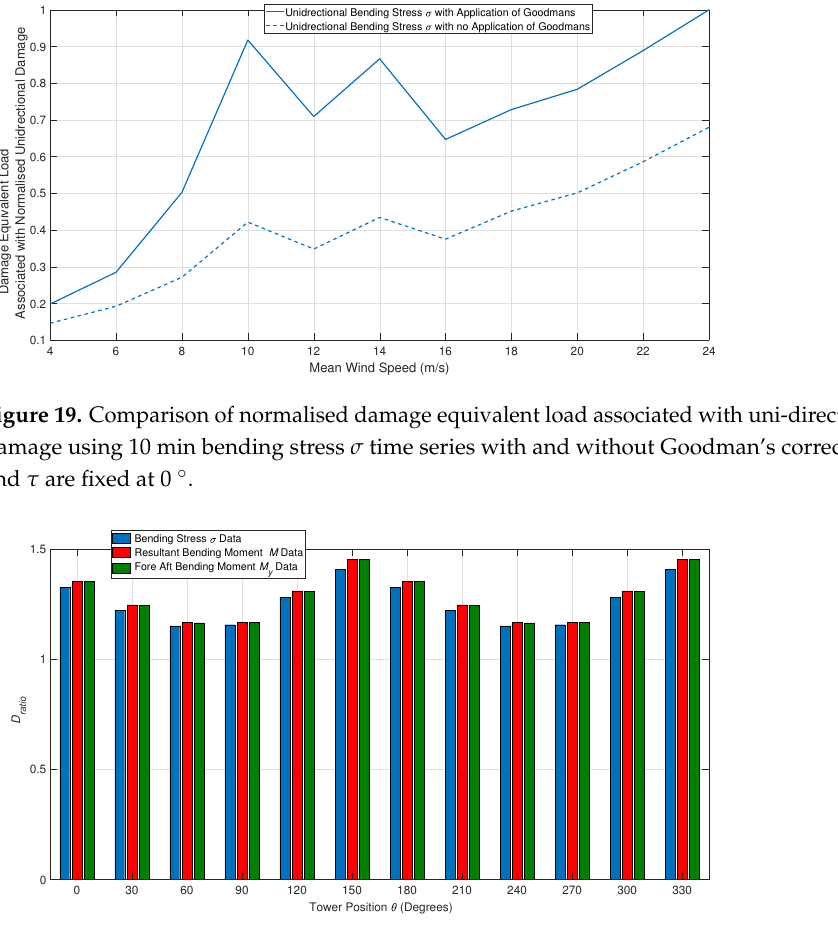
Figure 20. Absolute D ratio between uni-directional fatigue damage and fatigue damage at a range of tower positions θ for wind rose